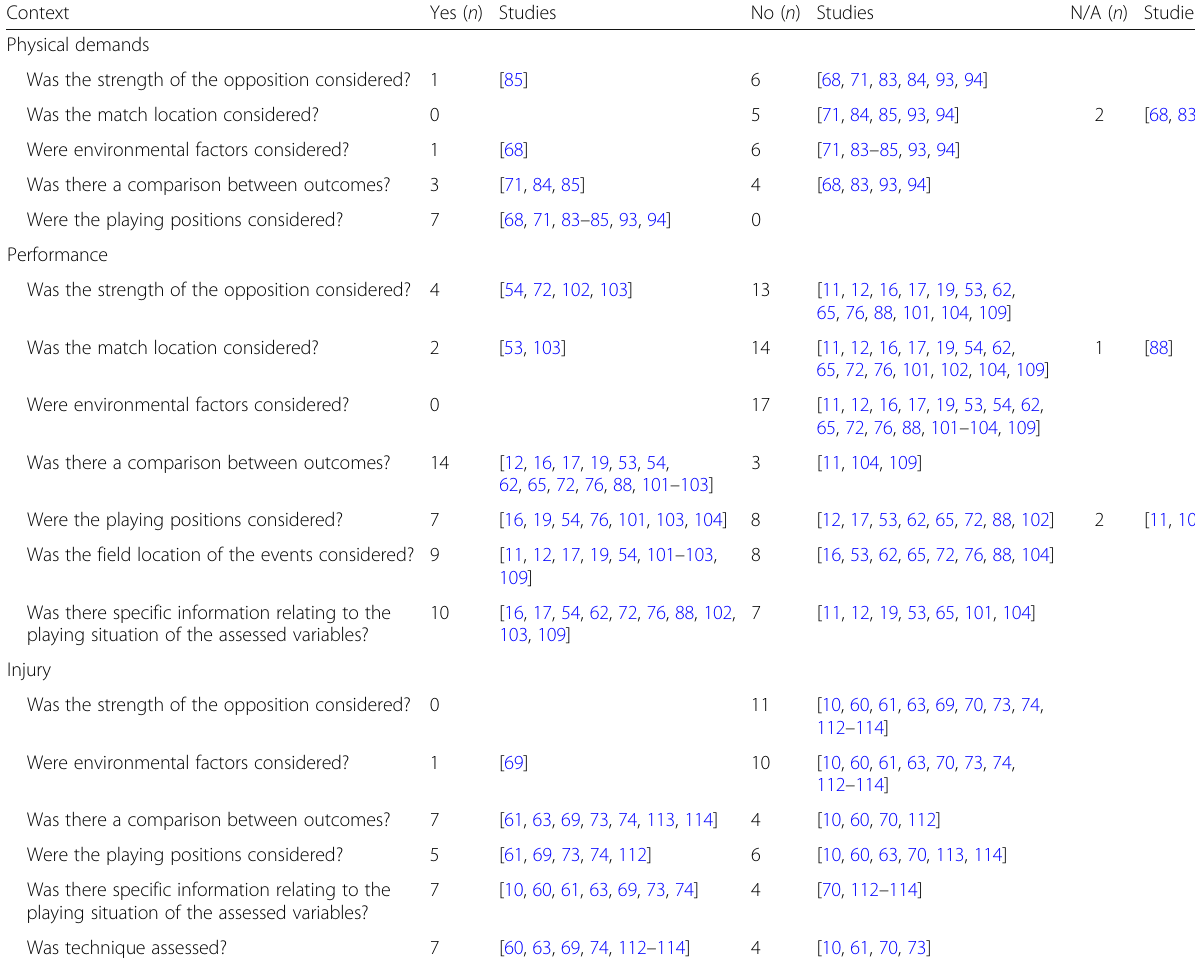
Table 6 A Summary of the ‘ how ’ studies that included contextual variables in the